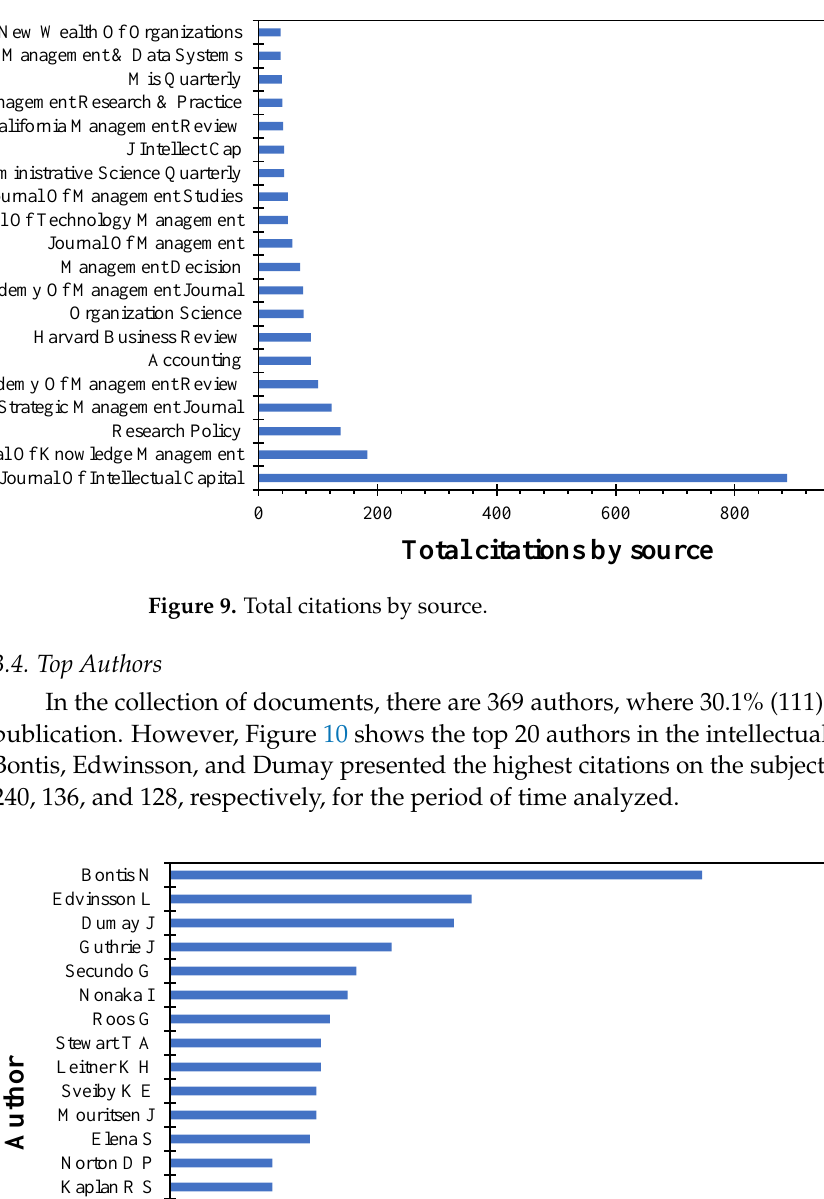
Figure 8. Importance of the 20 main sources.